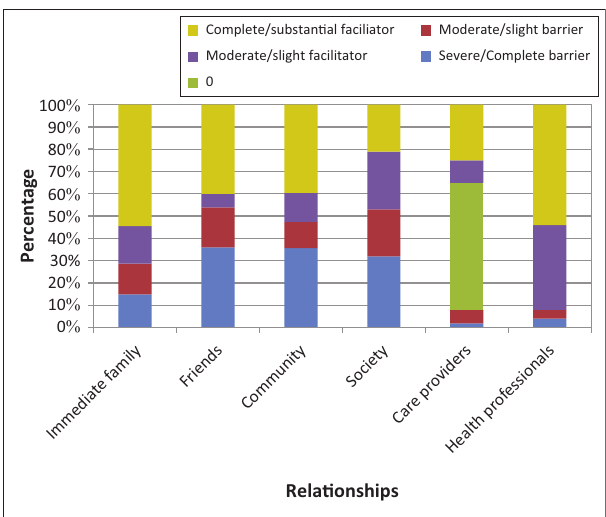
FIGURE 4: Attitudes experienced as barriers and facilitators ( n = 53).